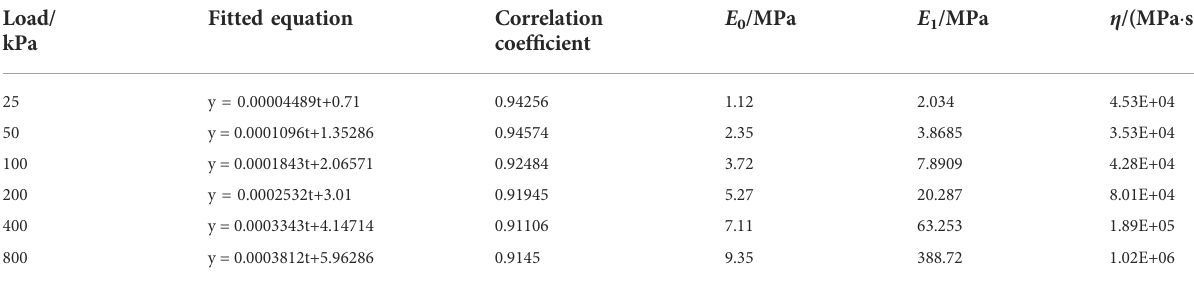
TABLE 5 Rheological model fi tting results and parameters of the samples when the ratio of bio-enzyme was 0.03%. Load/